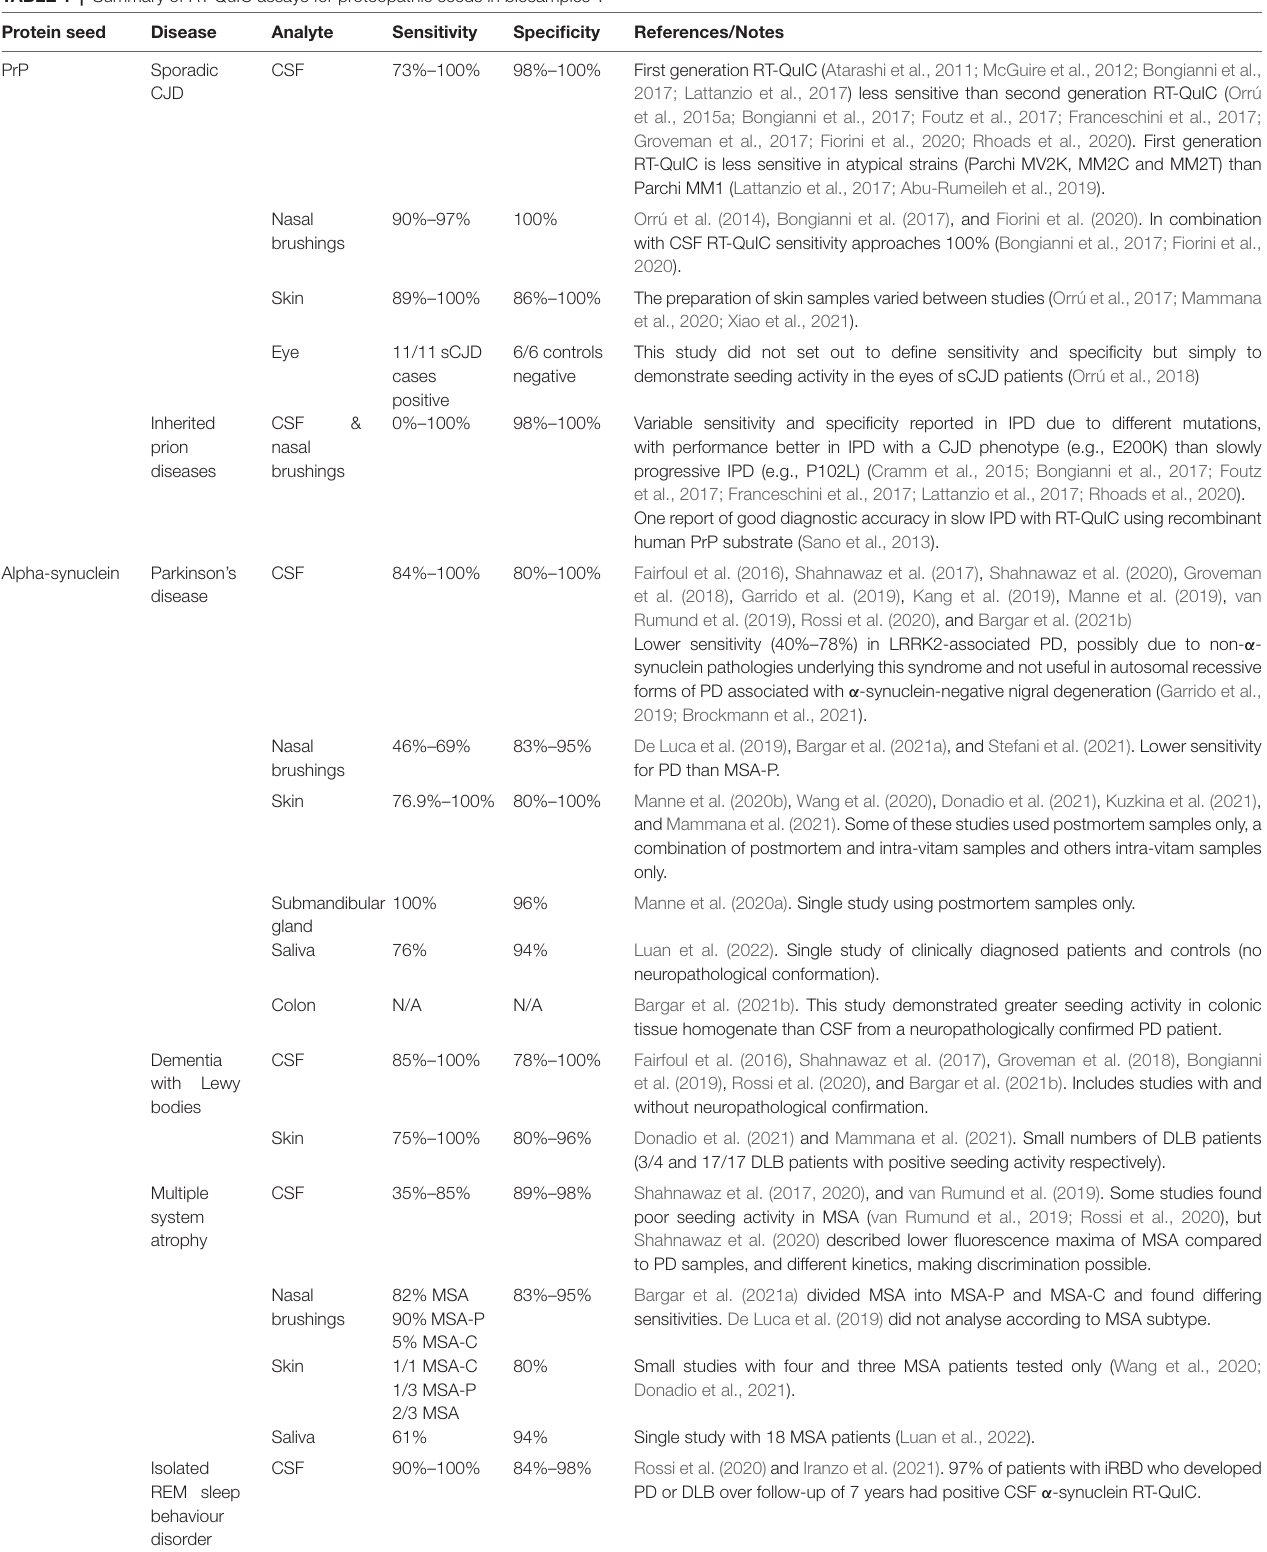
TABLE 1 | Summary of RT-QuIC assays for proteopathic seeds in biosamples a . Protein